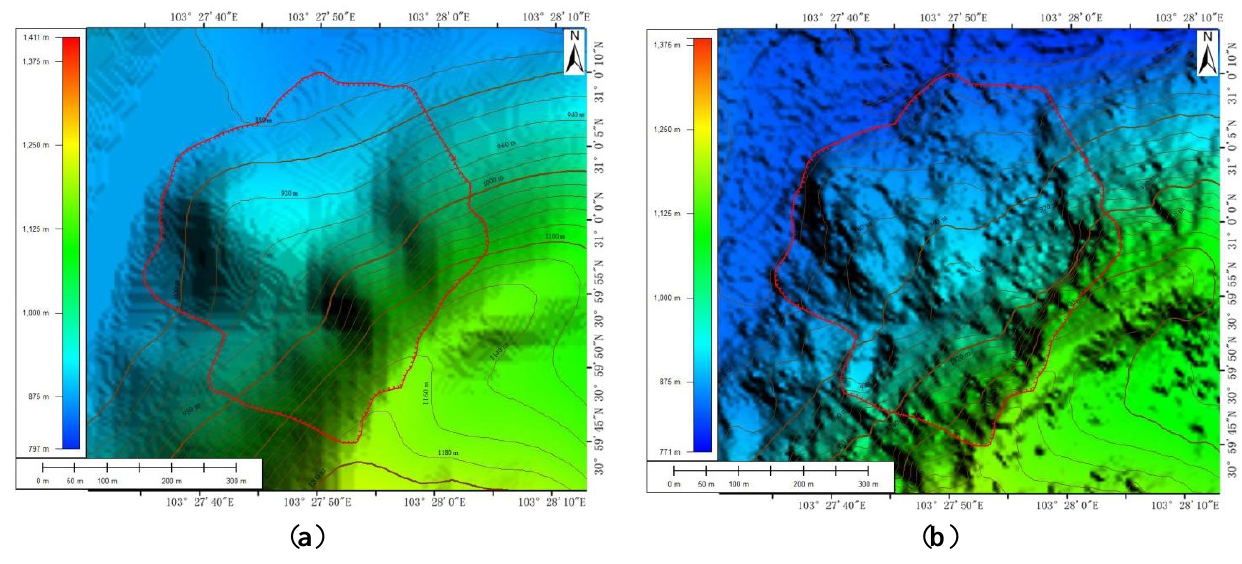
Figure 6. (a) Shaded relief of the pre-landslide DTM; (b) post-landslide DTM with contours. The landslide lies inside the red line.